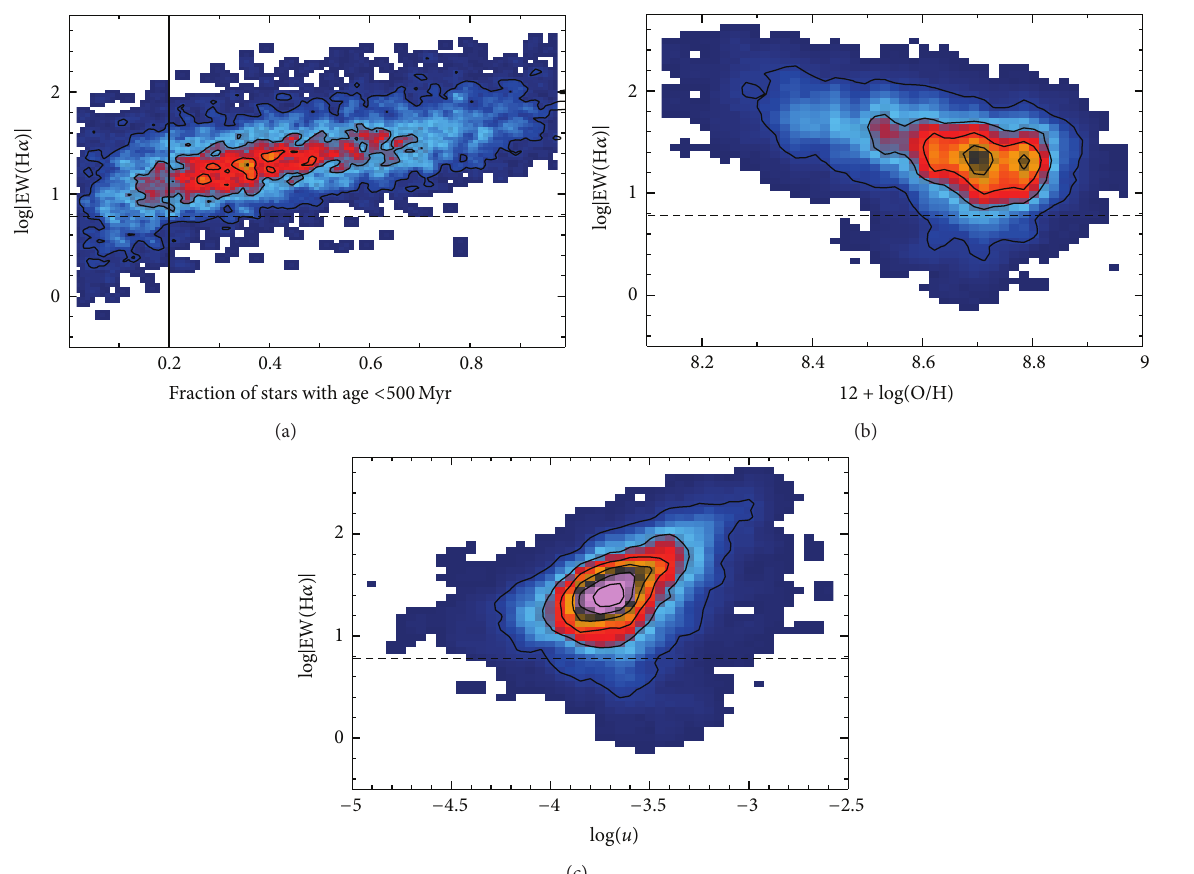
Figure 2: (a) Absolute value of the equivalent width of H 𝛼 , in logarithmic scale, plotted against the luminosity fraction of young stars in the 𝑉 -band, in the underlying stellar population (according to the SSP modelling by FIT3D) for the clumpy ionized regions selected with HIIexplorer. (b) Absolute value of the equivalent width of H 𝛼 , in logarithmic scale, plotted against the oxygen abundance for the same ionized regions. (c) Absolute value of the equivalent width of H 𝛼 , in logarithm scale, plotted against the ionization strength for the same ionized